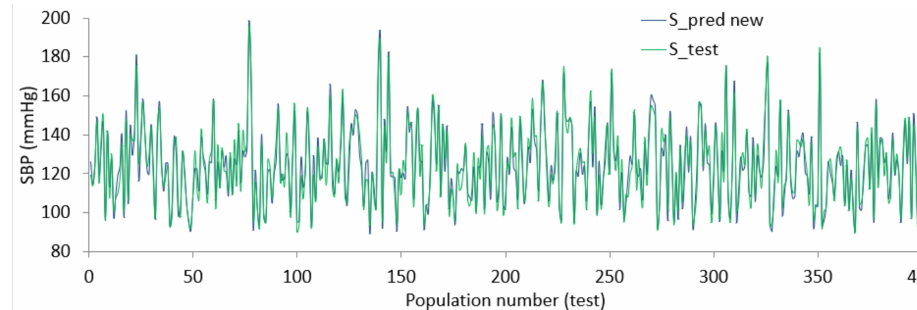
Figure 19. Predicted value against actual value for SBP.